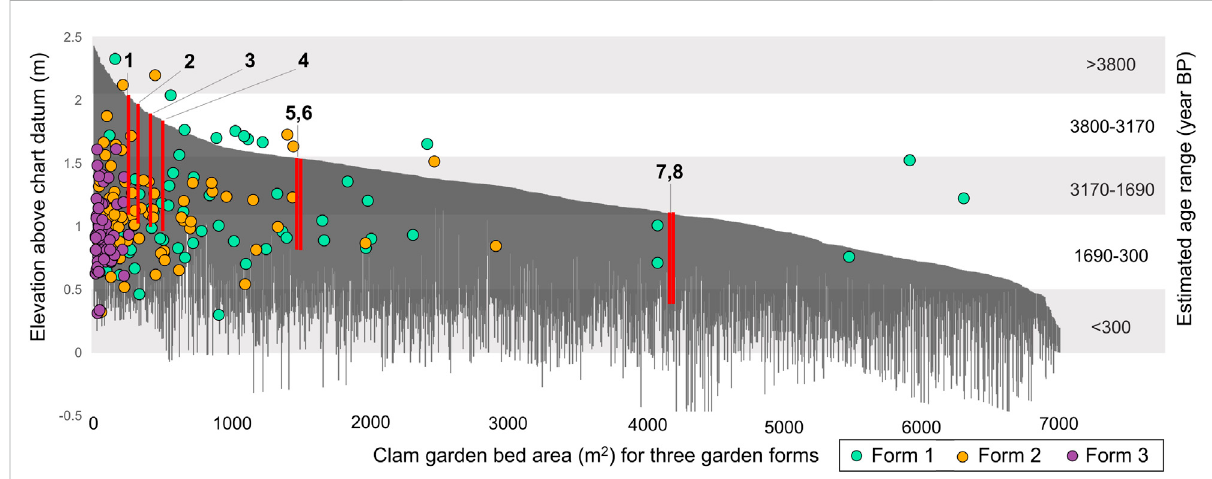
FIGURE 7 KanishBaybedarea(m 2 )ofthethreeformofclamgardens(coloreddots)superimposed overthedistributionofwallelevationsamples(vertical grey lines) arranged from highest to lowest above Canadian chart datum (Lower Low Water Large Tide; LLWLT). Red lines represent radiocarbon dates from clams recovered from under the garden walls (Smith et al., 2019, refer to Supplementary Table S1 for details). Time divisions